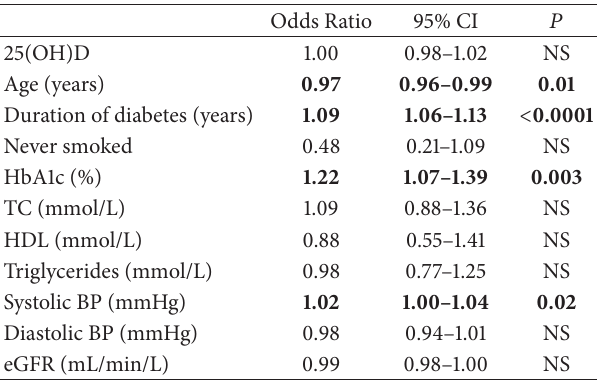
BMI:BodyMassIndex,BP:bloodpressure,TC:totalcholesterol,HDL:high- density lipoprotein cholesterol, ALP: alkaline phosphatase, CCa: corrected calcium, and eGFR: estimated glomerular filtration rate. in patients with maculopathy ( 15.9 ± 11.1 versus 19.2 ± 9.7 versus 9.1 ± 1.5 , 𝑃 < 0.0001 ) and systolic blood pressure ( 130±14 versus 134±14 mmHg, 𝑃 = 0.01 ) were significantly higher in patients with diabetes and maculopathy. There